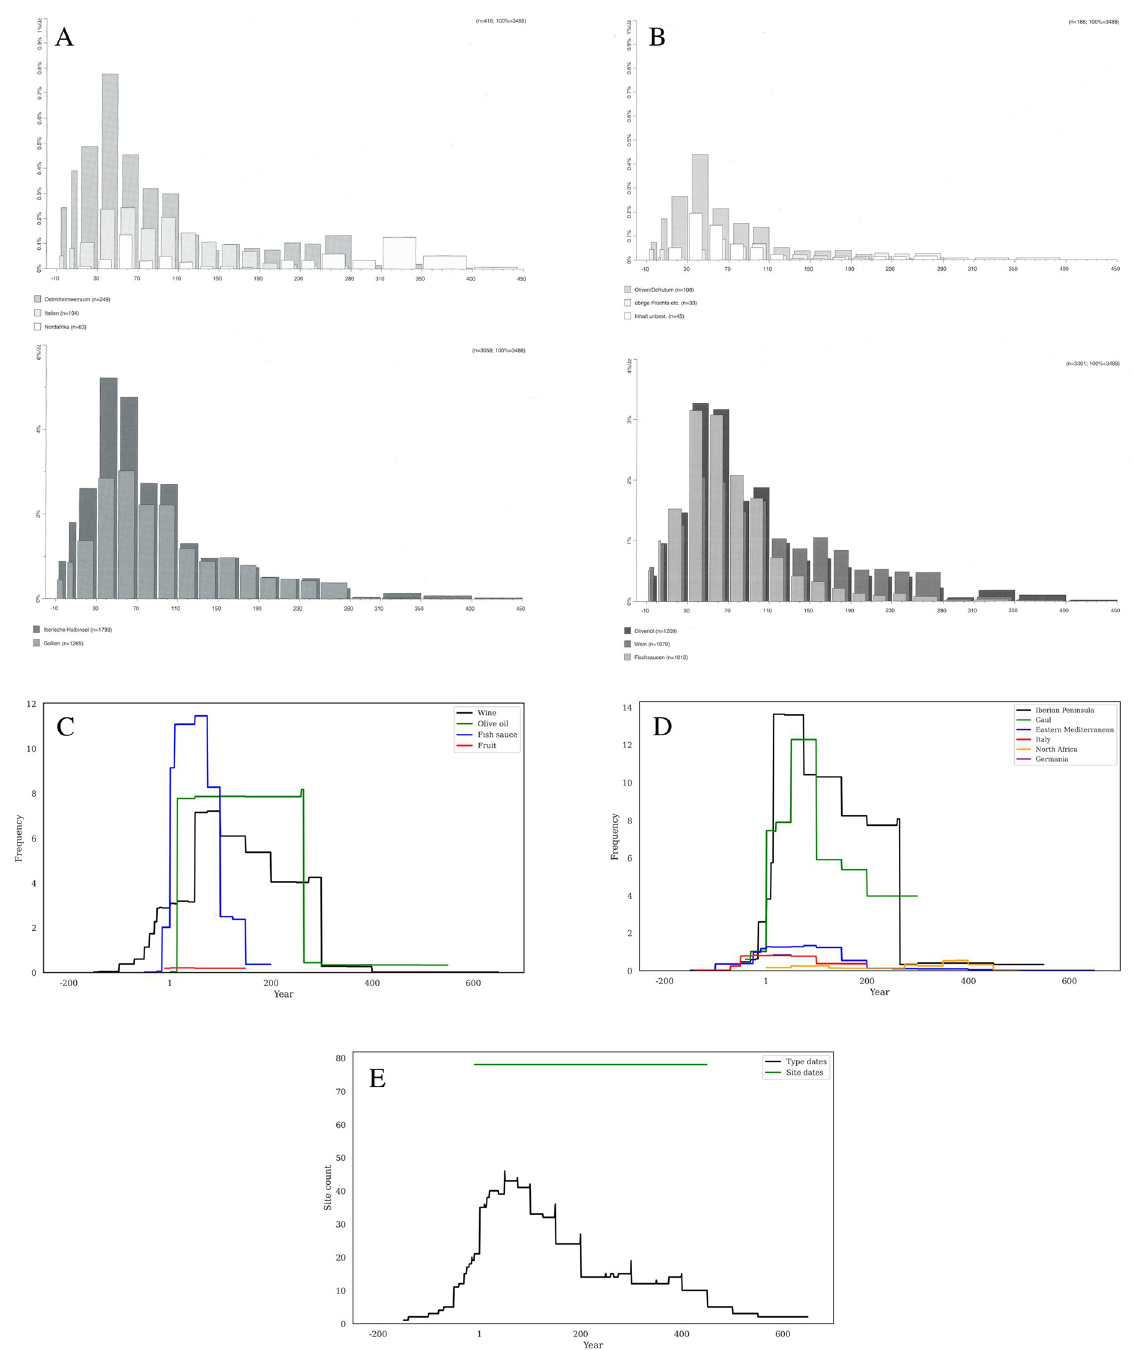
Fig 9. a-e. Amphorae consumption at Augst, Switzerland. Comparison of phased amphorae consumption data from Augst, Switzerland (Martin-Kilcher 1994 Figs 208 and 210 by contents (a) and origin (b)), with our analyses by origin (c), contents (d), and form diversity (e). Note that Y axes are not